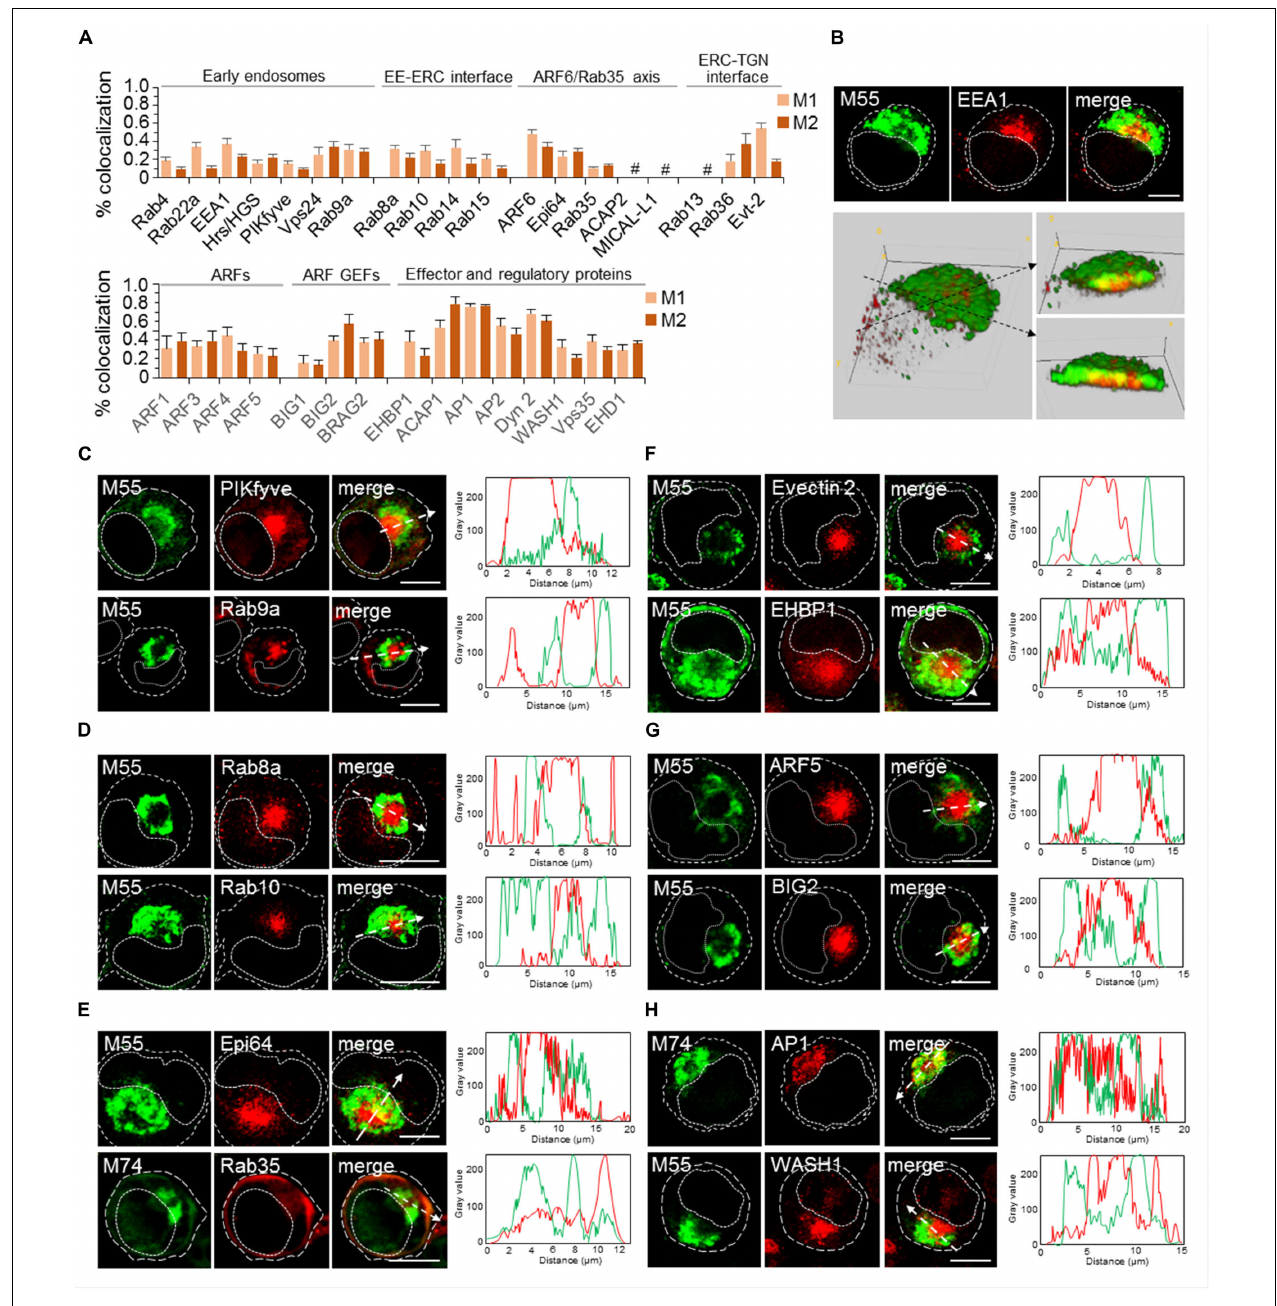
FIGURE 4 | Analysis of markers of early endosomes (EE), endosomal recycling compartment (ERC), and effector proteins that control scission at the EE-ERC-TGN interface at 48 hpi with MCMV. (A) 3D colocalization analysis of endomembrane markers with M55 protein based on M1/M2 coefficients of pixel overlap, determined on Costes-algorythm thresholded z-stacks of confocal images. Markers were visualized using Ab reagents ( Supplementary Table S2 ), and the sites of intracellular accumulation of viral envelope glycoproteins were visualized using mAb reagents to M55. Antibody reagents used are listed in Supplementary Table S1 . Data represent mean ± SEM per cell ( n = 6–10). #, not available due to the low signal in infected cells. (B) Example of 3D reconstruction of the AC based on expression of Rab5 and M55 protein in 48-h infected MCMV cells. Upper panel presents confocal slices obtained through the focal plane and lower panel 3D reconstruction of the entire z-stack (14 slices) using Image J Volume Viewer plugin. Images shown on the right (* and **) present the view across the section of stack indicated by dashed arrows. (C–H) ) Subcellular distribution of representative markers. Complete experiments are shown in the Supplementary Material ( Supplementary Figures S11–S15 ). Examples of the subcellular distribution of markers of EEs (C) , ERC (D) , ERC-associated Arf6/Rab35 axis (E) , ERC-associated effectors proteins (F) , ARF system (G) , and EE/ERC-associated scission machinery (H) . Shown are images through the focal plane and colocalization analysis by plotting fluorescence intensity profiles along white dashed lines. Cell borders are indicated by fine dashed lines and nuclei by fine dotted lines. Bars, 10 µ m. 2-column fitting image.